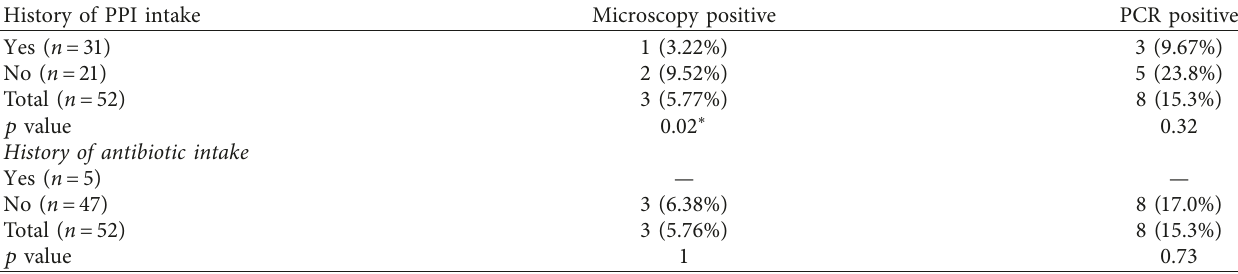
Table 3: History of PPI and antibiotic intake in comparison with diagnostic test positive for H. pylori